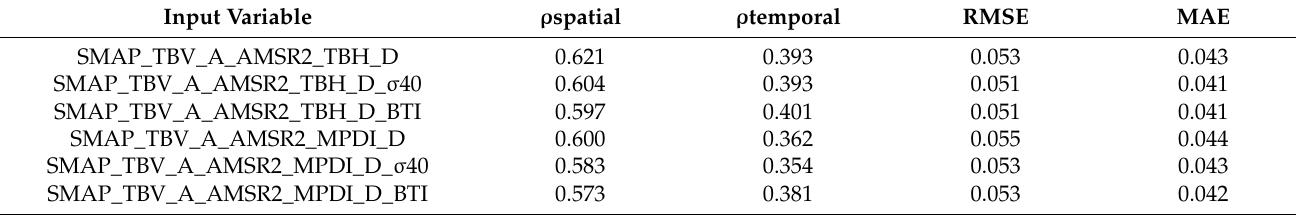
Table 4. Average quality index for soil moisture calculated by comparing different microwave observation combinations with data from